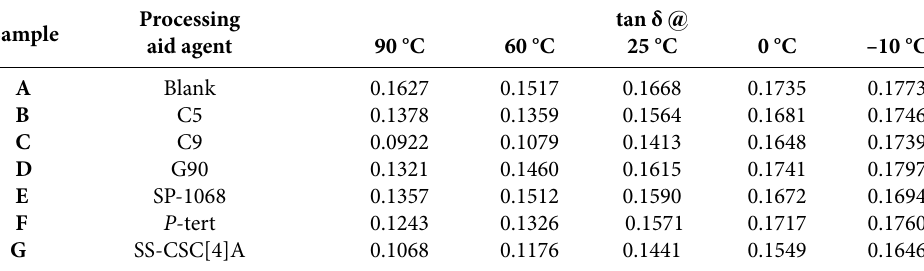
Table 6. tan δ at various temperature for compounds A-G derived by